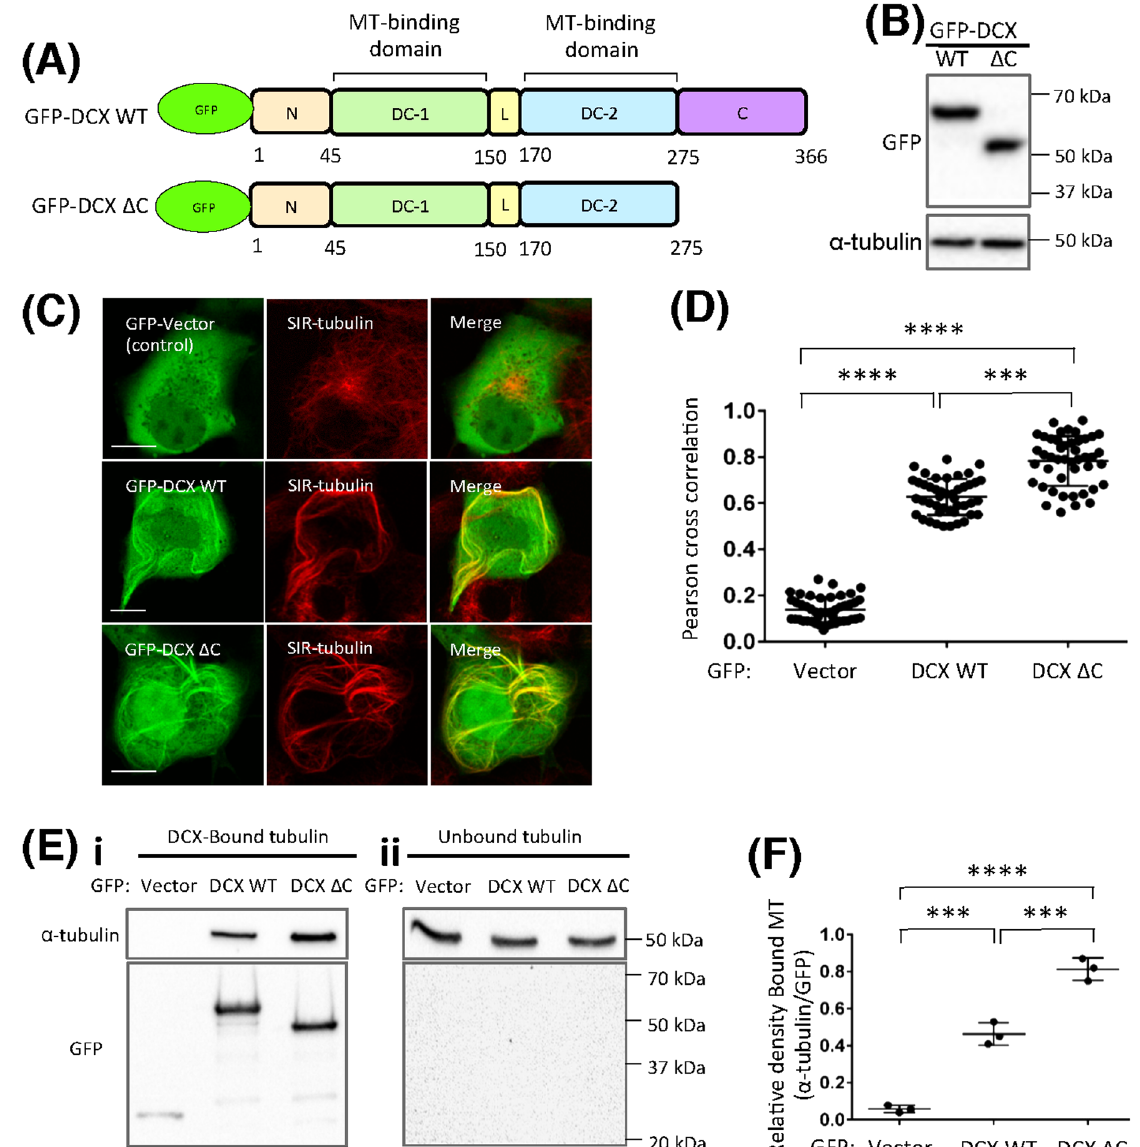
Figure 2. DCX C-terminal deletion increases DCX association with MTs and induces different MT bundling patterns. ( A ) GFP-tagged DCX full-length (wild-type, WT) and a DCX C-terminal truncation mutant lacking residues 276–366 (DCX Δ C) were created to test the impact of the DCX C-terminus on the association of DCX with MTs. ( B ) Following transfection into COS-1 cells, equivalent expression of the GFP-DCX constructs was detected by immunoblotting for GFP (upper panel), with equivalent protein loading detected by immunoblotting for total α -tubulin (lower panel). Blots for both GFP and α -tubulin were cropped. ( C ) GFP- DCX constructs were visualised as green by confocal laser scanning microscopy (left panels), and the impact on endogenous tubulin organisation was evaluated by staining with the live imaging dye SIR-tubulin (red, middle panels); merge images indicate the areas of colocalization (yellow) of GFP and SIR-tubulin. Scale bars represent 10 µ m. ( D ) The impact on endogenous tubulin organisation was evaluated by the Pearson correlation coefficient. ( E ) Cells expressing GFP (control vector), GFP-DCX WT and GFP-DCX Δ C were incubated with GFP-trap beads overnight. The GFP-trap beads bound to GFP-tagged constructs were separated from the supernatant by centrifugation. (i) The pellet fraction contains GFP-tagged constructs bound to tubulin (DCX- bound tubulin) and (ii) the supernatant fraction contains soluble tubulin (unbound tubulin). Immunoblotting was performed to detect endogenous α -tubulin (upper panel) or GFP (lower panel). Blots for α -tubulin were cropped. ( F ) Co-precipitation of MTs with GFP-DCX proteins was estimated from quantitating the tubulin/ GFP ratio in each pellet fraction containing DCX-bound tubulin. Error bars represent the standard error of the means and asterisks indicate values calculated to be statistically significantly different ( ** p ≤ 0.01, *** p ≤ 0.001, **** p ≤ 0.0001 n = three independent